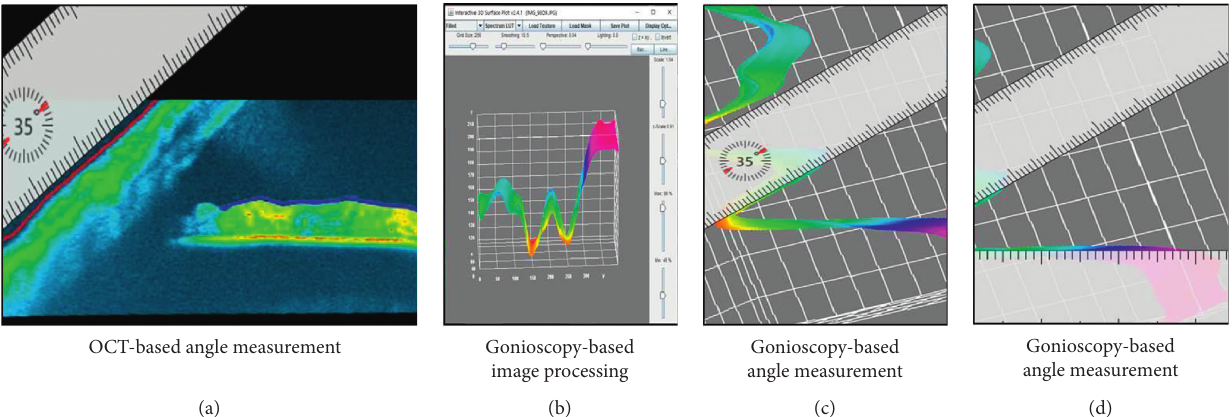
Figure 2: 3D measurement of the image intensity and angle from gonioscopy images in comparison to angle measurements obtained by anterior OCT. A gonioscopy-based image processing includes intensity adjustment and clipping of the intensity range, followed by angle measurement; for comparison, the corresponding angle obtained by anterior OCT measurement is shown. (a) OCT-based angle mea- surement. (b) Gonioscopy-based image processing. (c) Gonioscopy-based angle measurement. (d) Gonioscopy-based angle